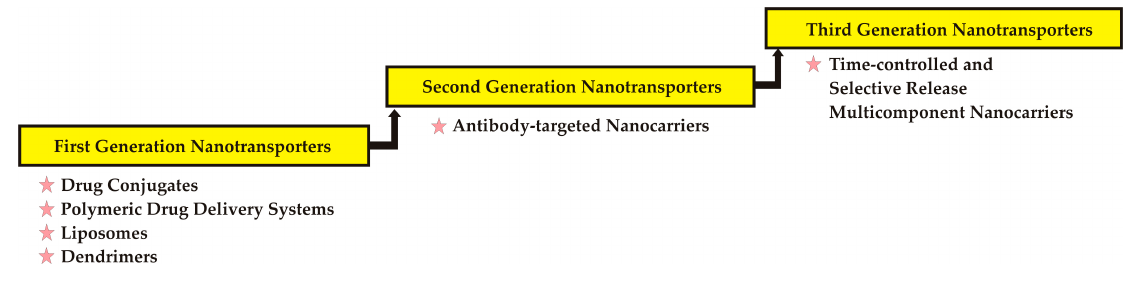
Figure 2. Evolution of nanocarriers.